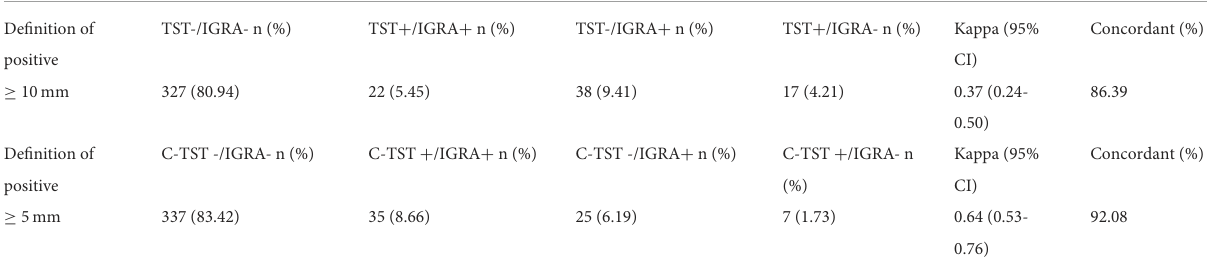
TABLE 3 Agreement between baseline IGRA results and TST/C-TST results at the baseline and 3-month follow-up survey. Agreement between IGRA results and TST/C-TST results at baseline